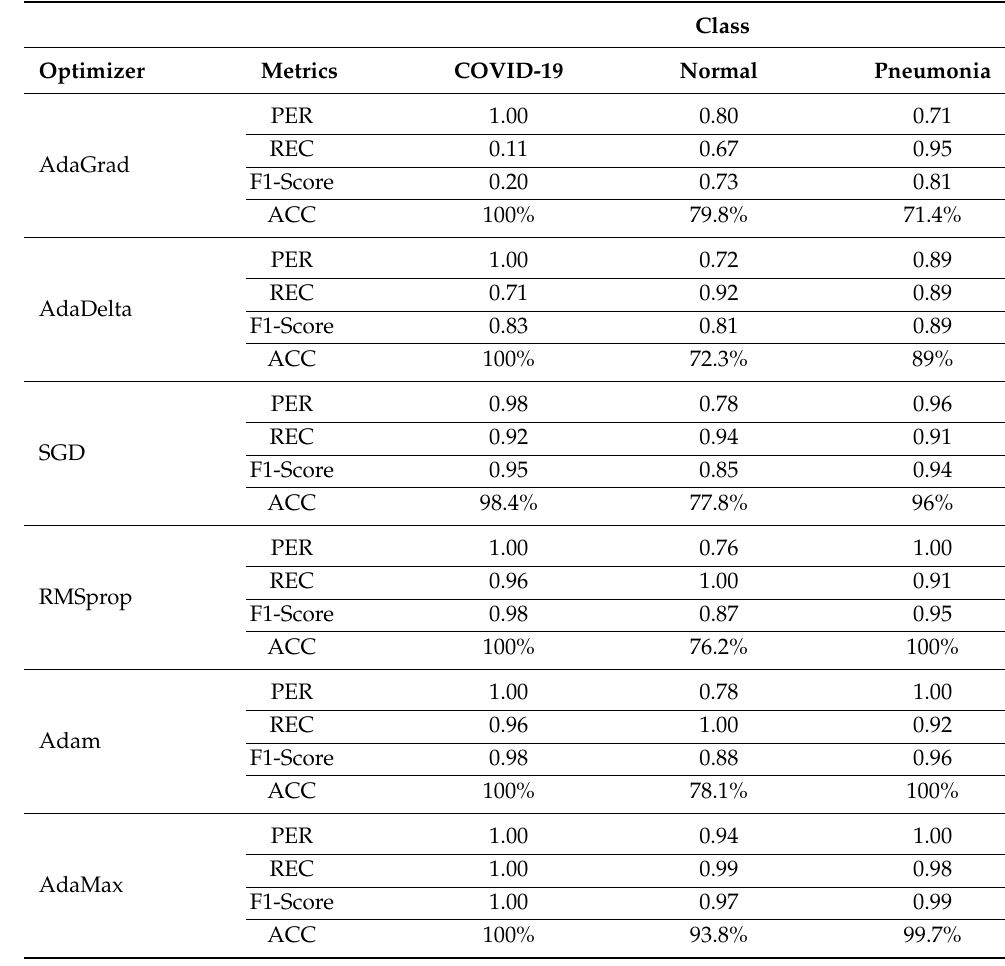
Table 5. Comparative analysis of each class and overall accuracy using different optimizers with the ELU activation function set at α =